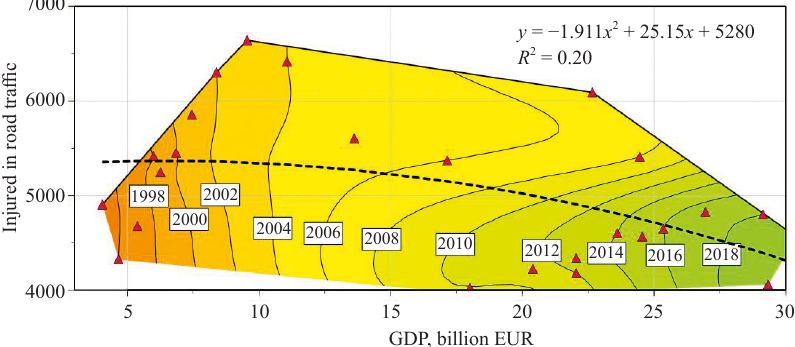
Figure 13. Number of injuries in road traffic with increasing